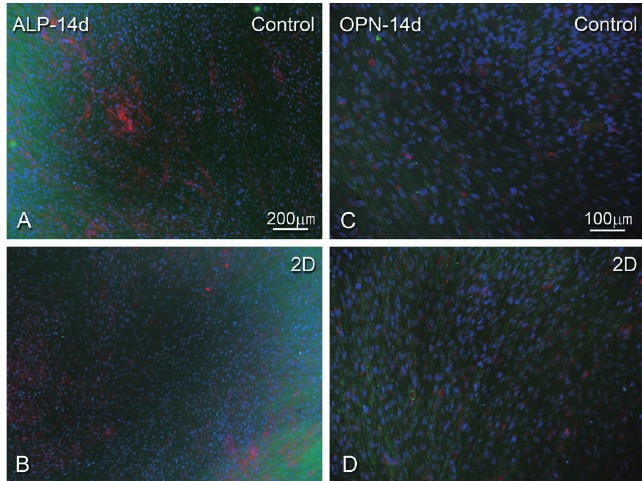
Figure 3- hPDLF cells grown on bi-dimensional surfaces, control and at 14 days. Epifluorescence of actin cytoskeleton labeling (phalloidin labeling, green fluorescence), DNA stain (DAPI, blue fluorescence), alkaline phosphatase (ALP) (A-B) and osteopontin (OPN) labeling (C-D) (red fluorescence). Bar A-B: 200 µm and Bar C-D: 100 µm